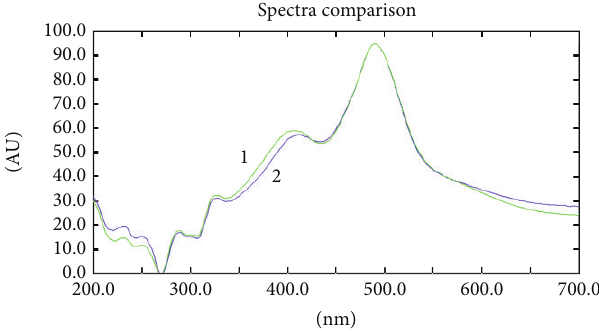
Figure 2: Spectrodensitometric analysis. 1: standard; 2: